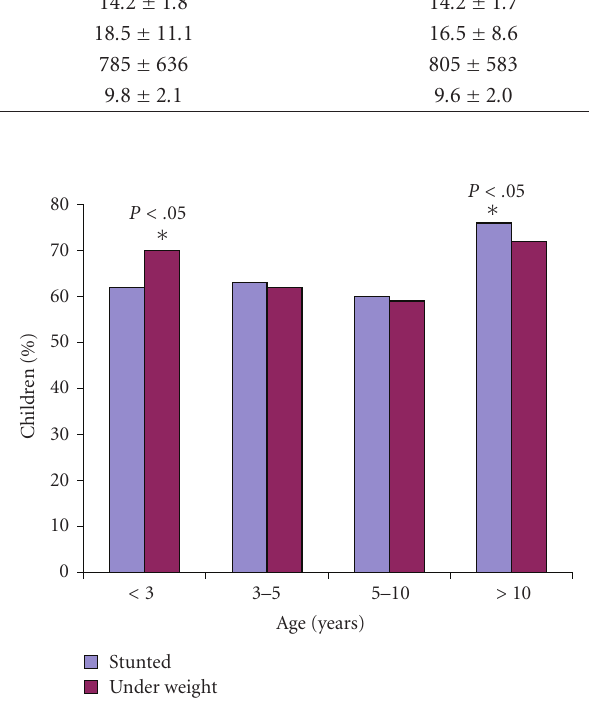
Figure 1: Proportion of children with underweight (WAZ < − 2 SD) and stunting (HAZ < − 2SD) in di ff erent age groups. ∗ P < . 05 versus 3–5 and 5–10 years age